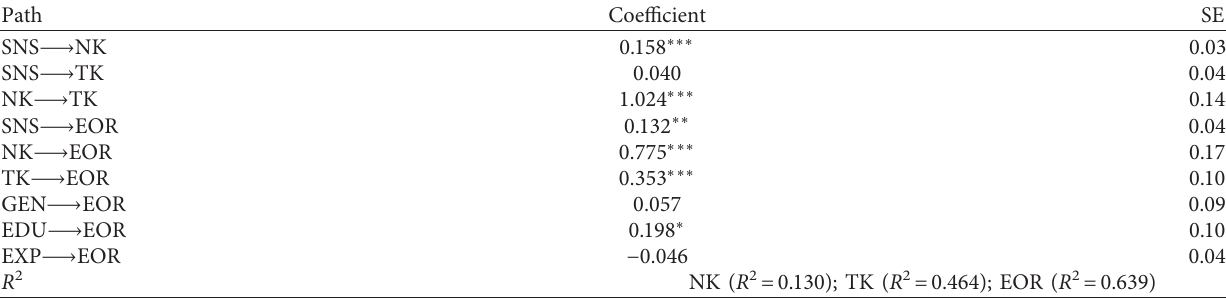
Table 4: Coefficient estimates for the structural equation model.